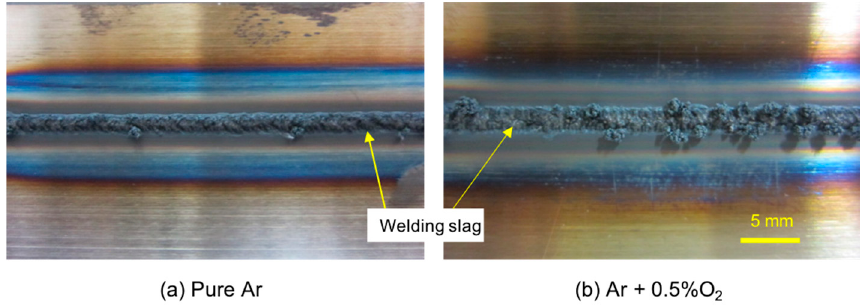
Figure 13. Welding slag appearance on the bottom surface of the base metal. ( a ) Pure Ar, ( b ) Ar + 0.5% O 2 .